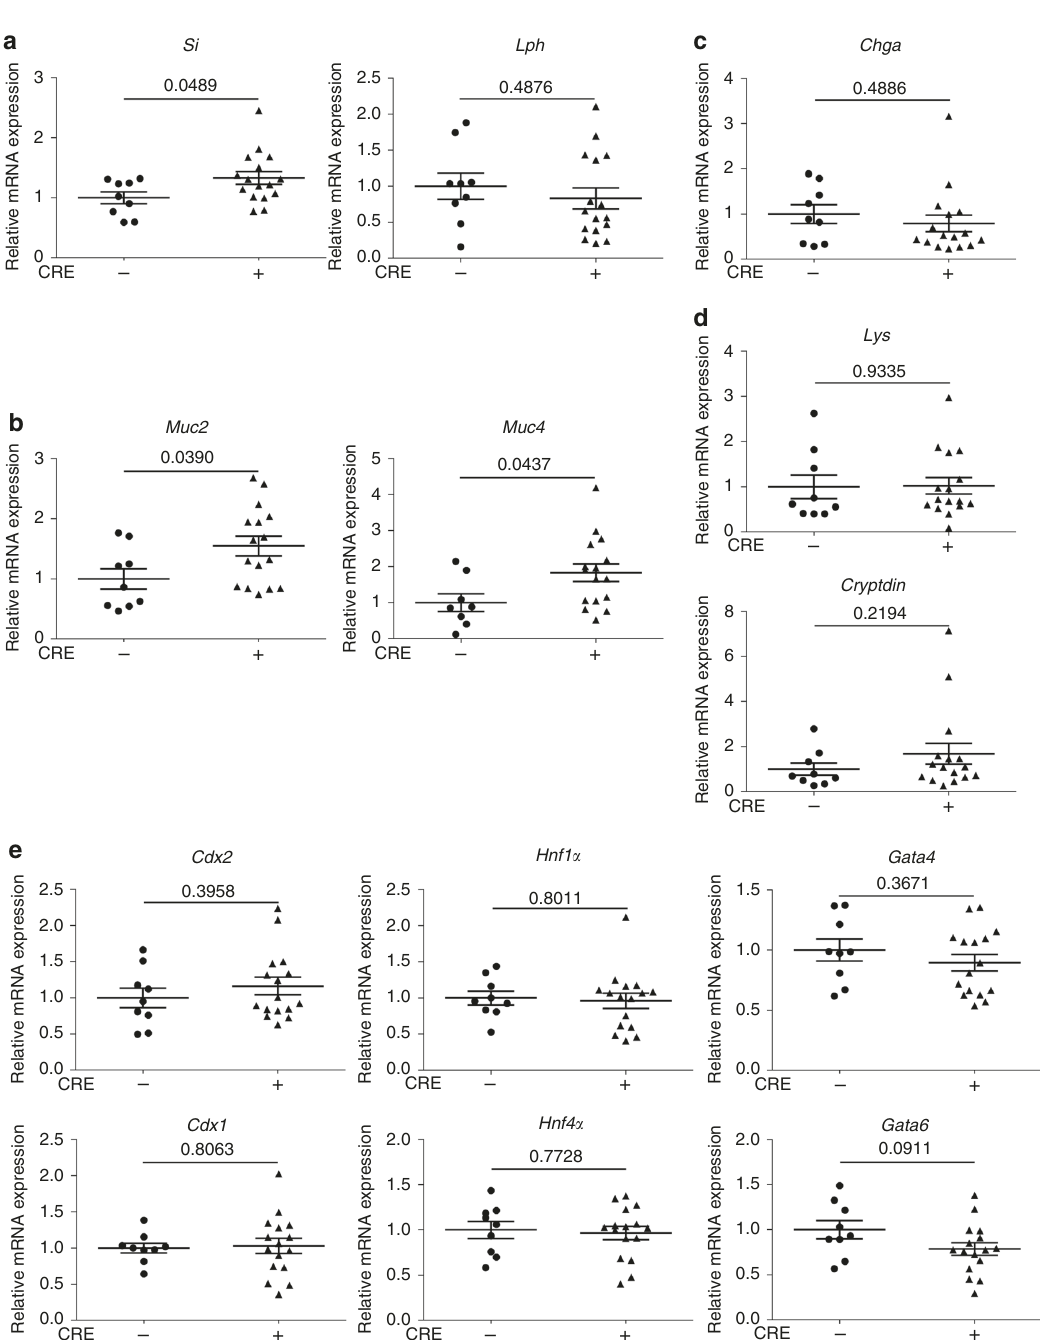
Fig. 4 H2a.z controls the expression of differentiation marker mRNAs in vivo. 10 – 15 mice per indicated genotypes were fed a tamoxifen-containing diet for 10 days, sacri fi ced and the small intestinal mucosae were harvested and total RNA extracted, as indicated in the Materials and Methods. qPCR was then performed for the detection of enterocyte ( a ), goblet ( b ), entero-endocrine ( c ), and Paneth ( d ) cell markers. β 2m-normalized values for each mouse were plotted relative to 1 for the mean of control (-CRE) mice. Means and standard errors are represented and the Student ’ s t -Test p -value is indicated for each gene. e Same as in a – d for intestine-speci fi c transcription